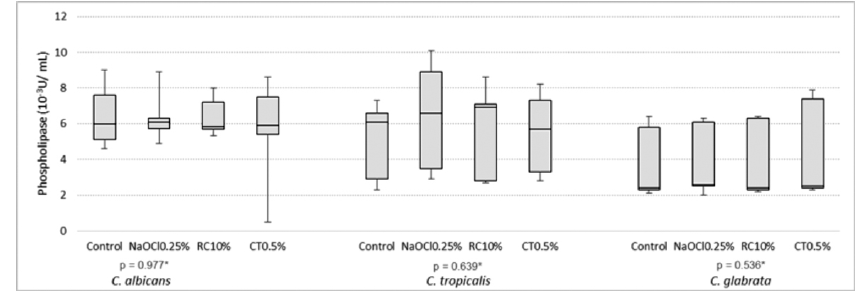
*Kruskal-Wallis test. Figure 4- Comparison of phospholipase (10 -3 U/ mL) production by Candida spp. after immersion of the specimens in the disinfectant solutions and water